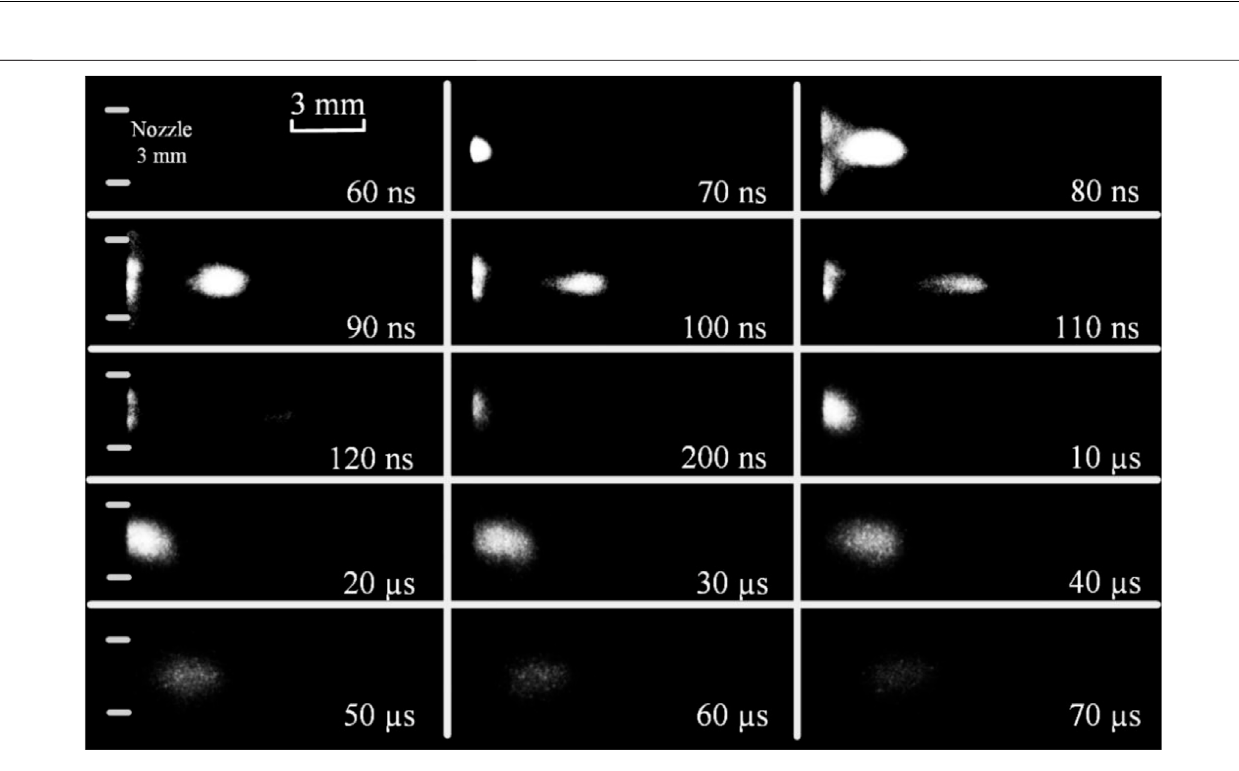
Frontiers in Physics |